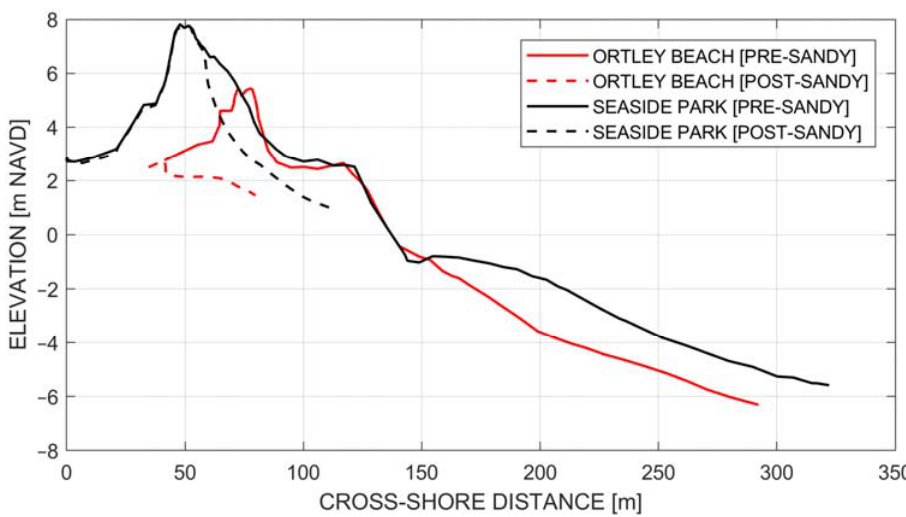
Figure 1. Pre- and post-Sandy beach profiles at Seaside Park (black) and Ortley Beach (red). Data reproduced from The Stockton University Coastal Research Center [16].